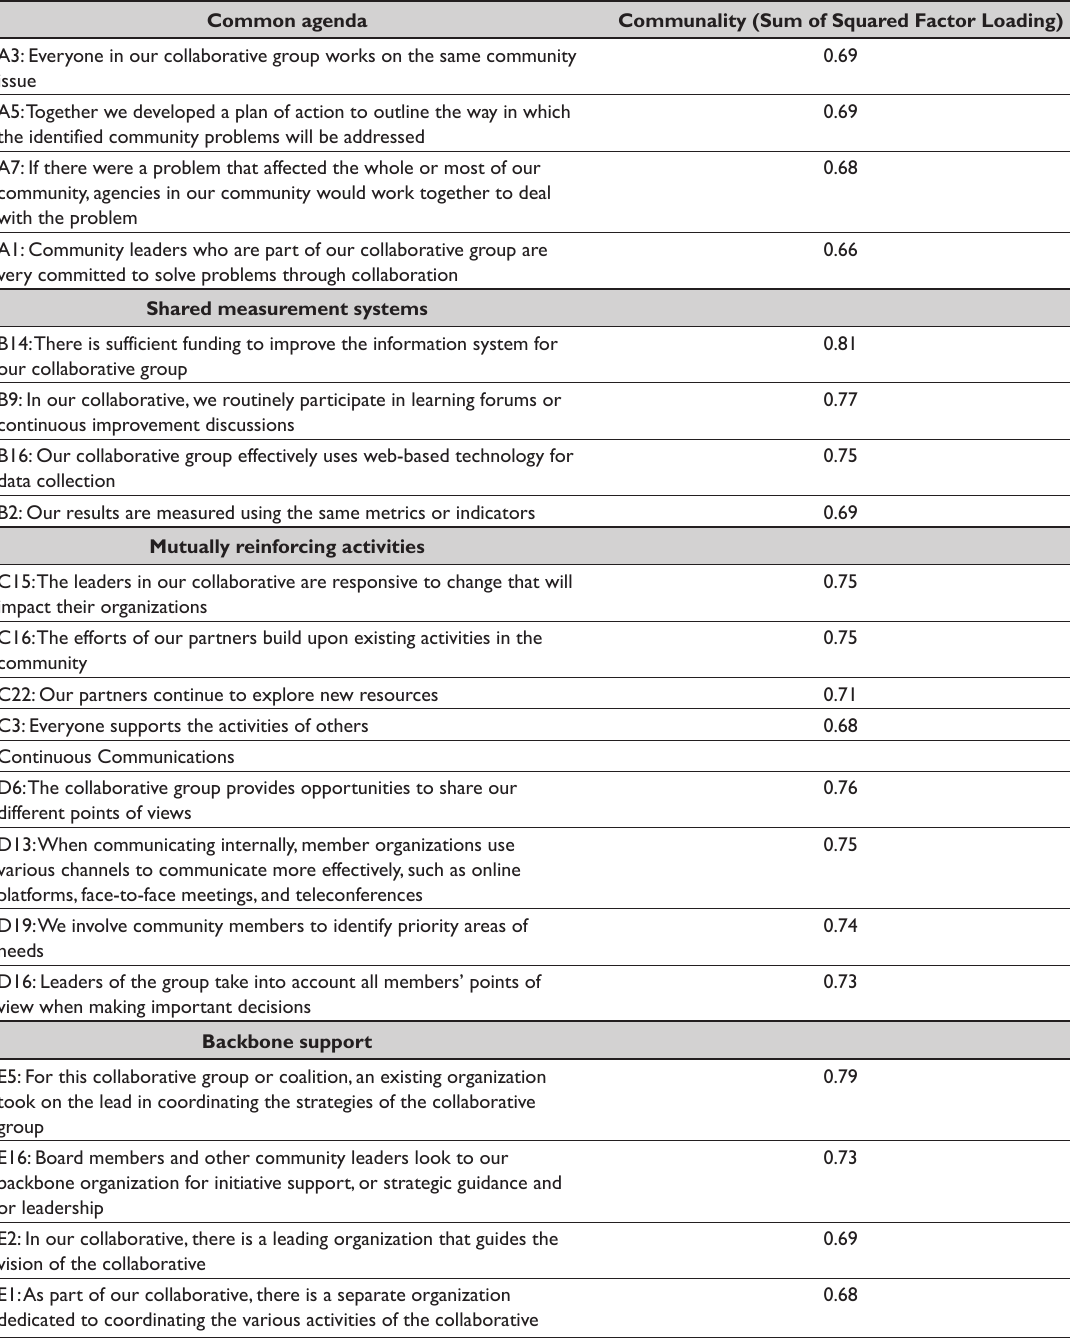
Table 3: Communalities of extracted components (Initial Set at